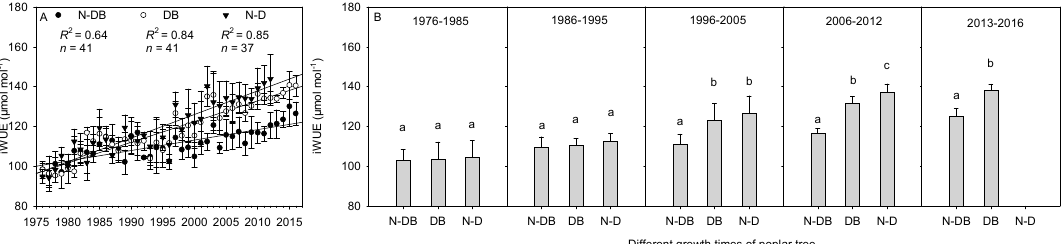
Figure 7. Difference in intrinsic water-use efficiency ( A , B ) among now-dead (N-D), dieback (DB), and non-dieback (N-DB) poplar trees at different growth times. Lower case letters indicate significant differences ( p < 0.05).